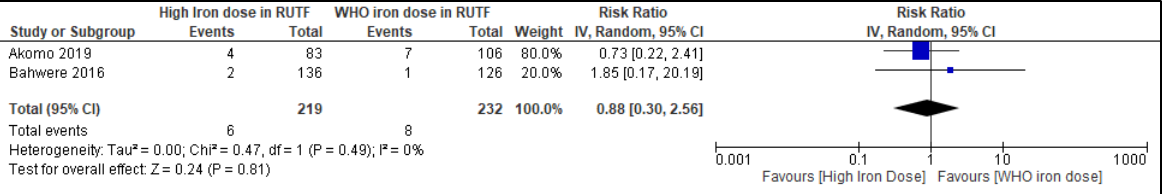
Figure 5. Effect of SMS-based RUTF with high iron content compared to peanut-based RUTF with WHO standard iron content on severe anemia (Blood Hemoglobin < 9 mg/dL). The forest plot shows pooled data from two studies. Data were available only for a subset of population from both the studies. The blood hemoglobin results were not adjusted for altitude and ethnicity. The data